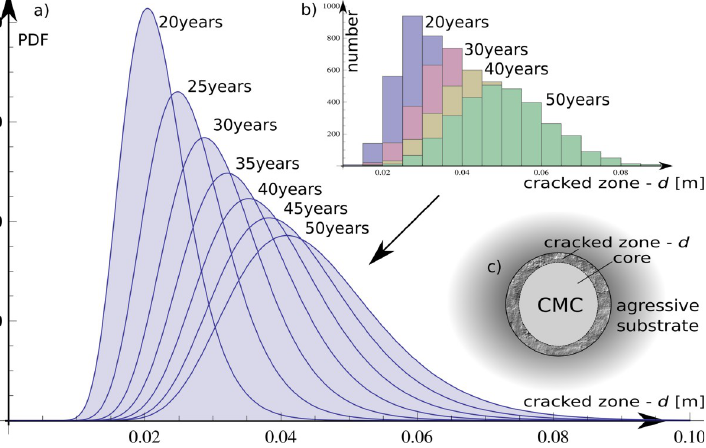
Fig 7. Deterioration depth over lifetime as a result of probability separated calculations: a) fit log-normal PDFs; b) histogram from raw results in every 10-year period.